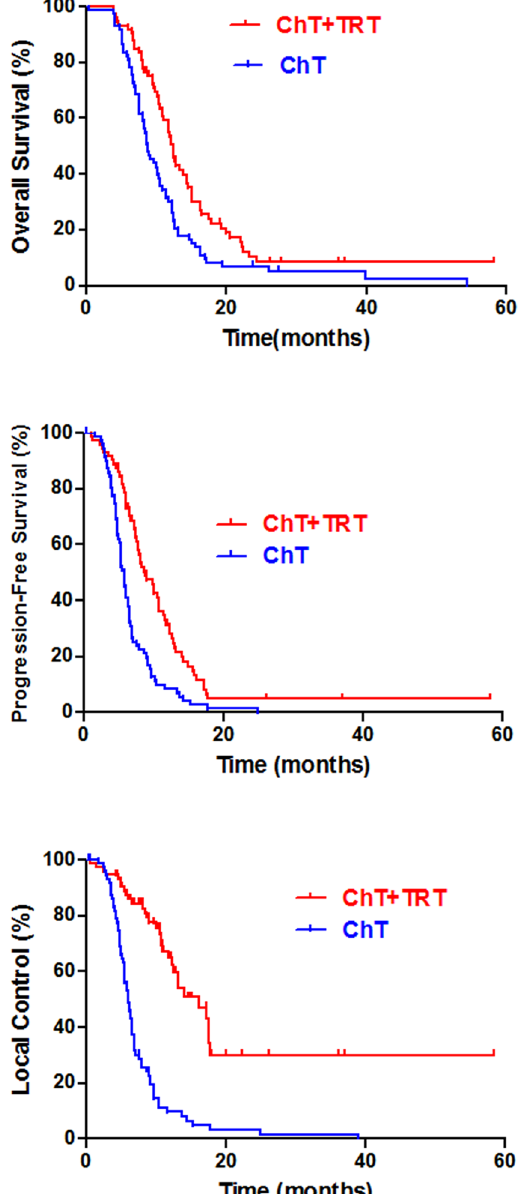
Figure 2. Thoracic radiotherapy improved the 2-year OS, PFS, and LC for polymetastatic SCLC